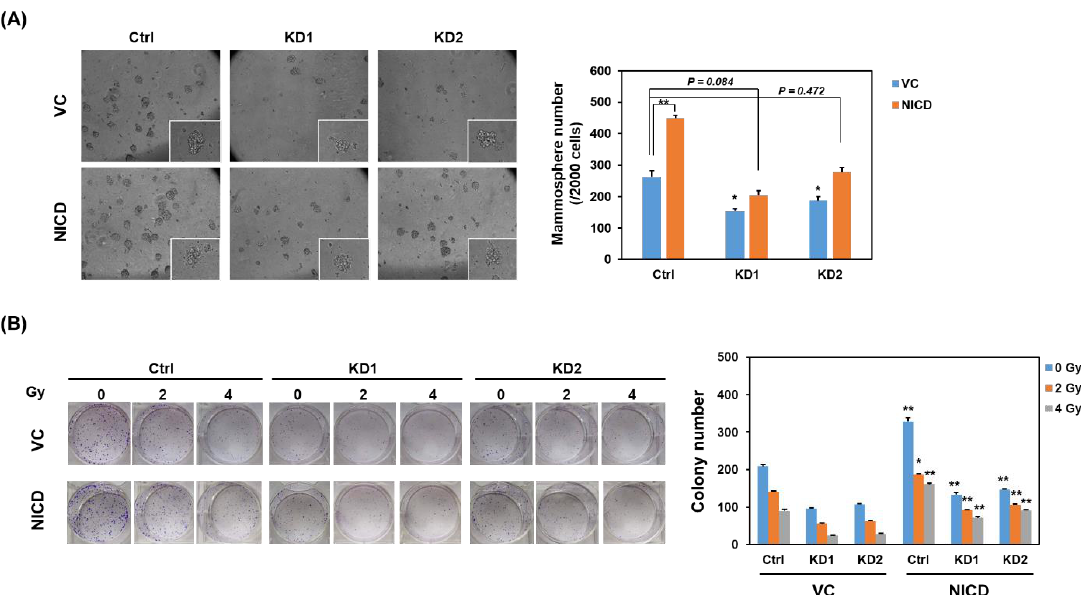
Figure 3. Forced expression of NICD reversed the inhibitory effect of TRIB3 knockdown in radioresistant TNBC cells. 231-RR cells were transfected with control vector (VC) or NICD plasmid (NICD) for 24 h followed by lentiviral transduction of TRIB3 specific shRNAs (KD1 or KD2) or sh-LacZ (Ctrl) for 48 h. ( A ) Cells performed mammosphere cultivation and formed mammospheres were counted at day 7. ** p < 0.01; * p < 0.05 when compared with the VC/Ctrl group. ( B ) Cells were seeded in 6 well-plates and received irradiation of 2 or 4 Gy. After 1-week cultivation, the formed colonies were stained by crystal violet and counted by Image J software. * p < 0.05; ** p < 0.01 when compared with VC groups of the same irradiation dosage.